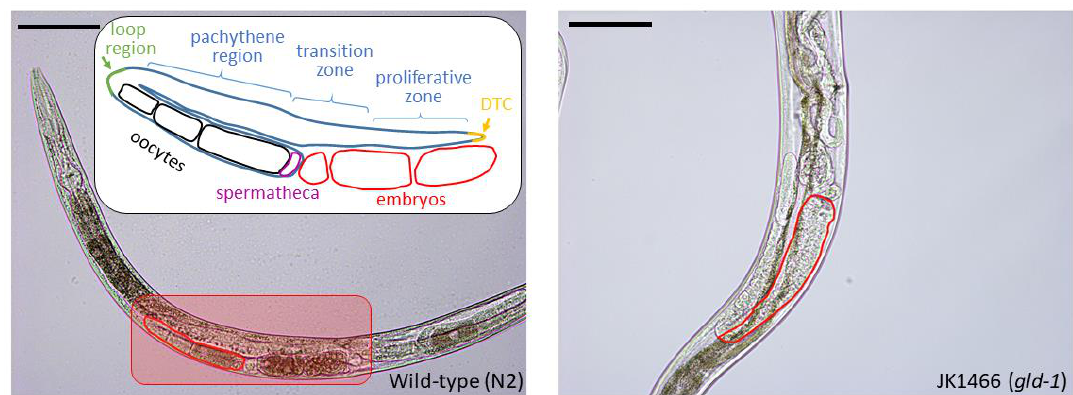
Figure 1. Objective evaluation method of tumor size in Caenorhabditis elegans . Comparison of germline phenotype of wild-type hermaphrodites and the gld-1 mutants. Each panel shows one adult hermaphrodite on day 4 of adulthood. Gonad arms have been outlined in red and measured as viewed in BF (Bright-field) with 20× lens in a Leica DM 2500 LED microscope. Scale bar, 100 μm. On the left, BF image of a wild-type worm and their developed oocytes. Outlined region from loop region to proximal region has been measured (2100 μm 2 ). Inset: Scheme for normal gonad morphology outlining zones and the development from oocytes to embryo. On the right, BF image of a gld-1 mutant which contains proliferative cells throughout the entire gonad arm. Outlined region from loop region to proximal region has been measured (6836 μm 2 ). Scale bar, 100 μm.